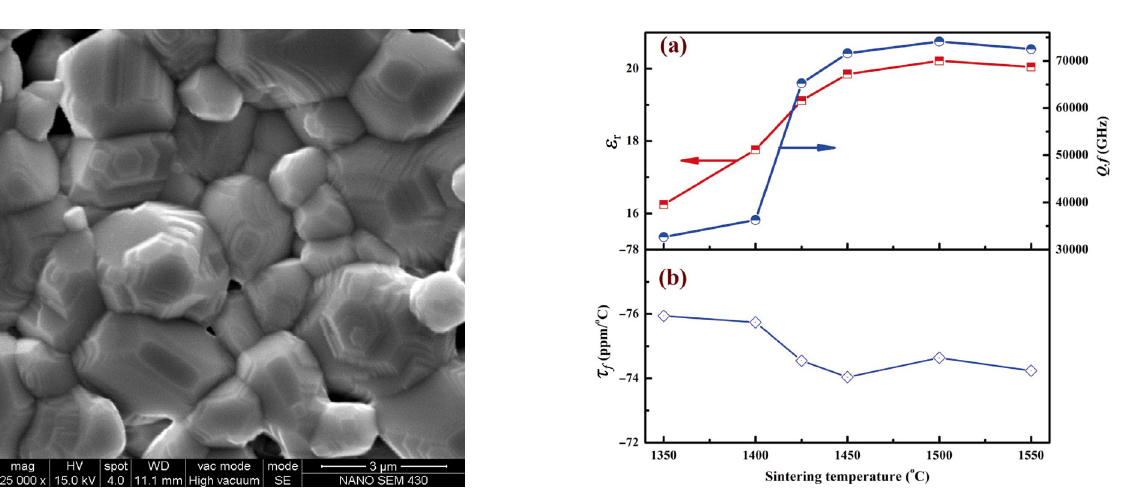
Fig. 8 SEM image of the sintered ceramics at 1500 ℃ for 4 h.